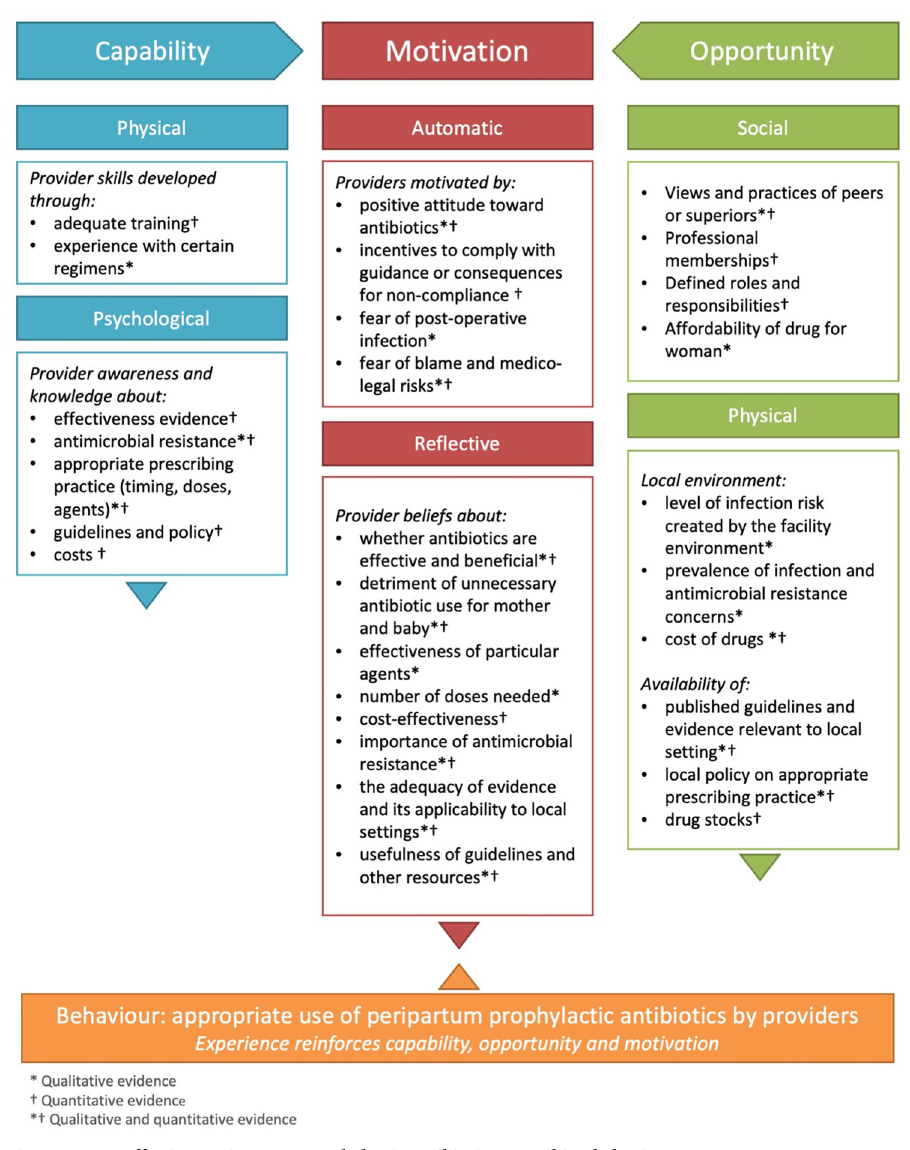
Fig 2. Factors affecting peripartum prophylactic antibiotic prescribing